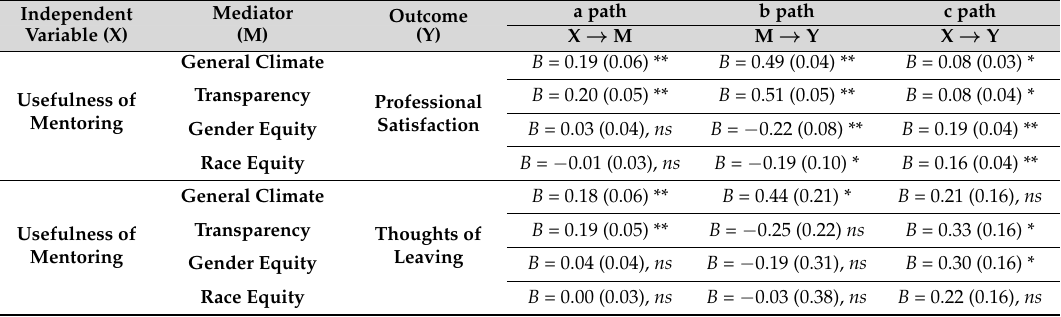
Table 5. Effect of mentoring on professional satisfaction and thoughts of leaving, as well as department